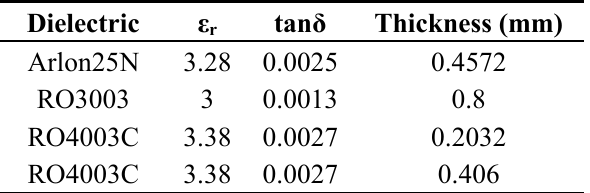
Table 2. Flexible dielectrics